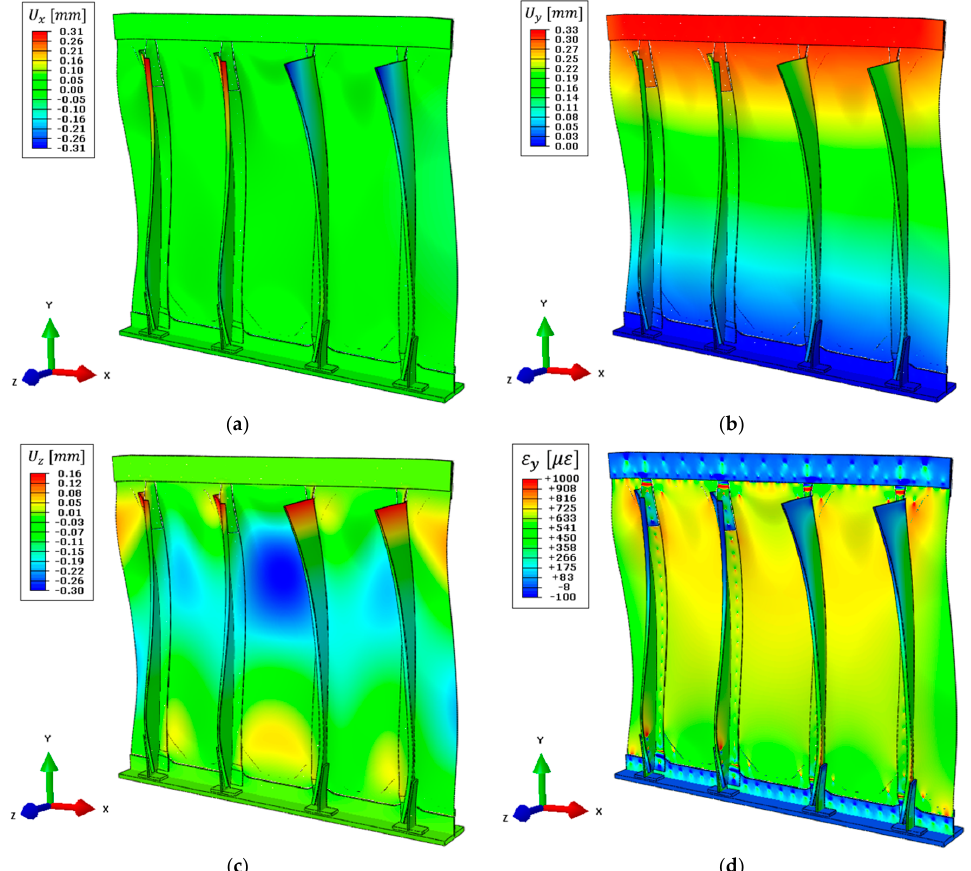
Figure 10. Direct FEM results, deformed shape with scale factor 100: ( a ) Displacement field on the x-direction, ( b ) displace- ment field on the y-direction, ( c ) displacement field on the z-direction, and ( d ) strain field on the y-direction on the top side of the structure.